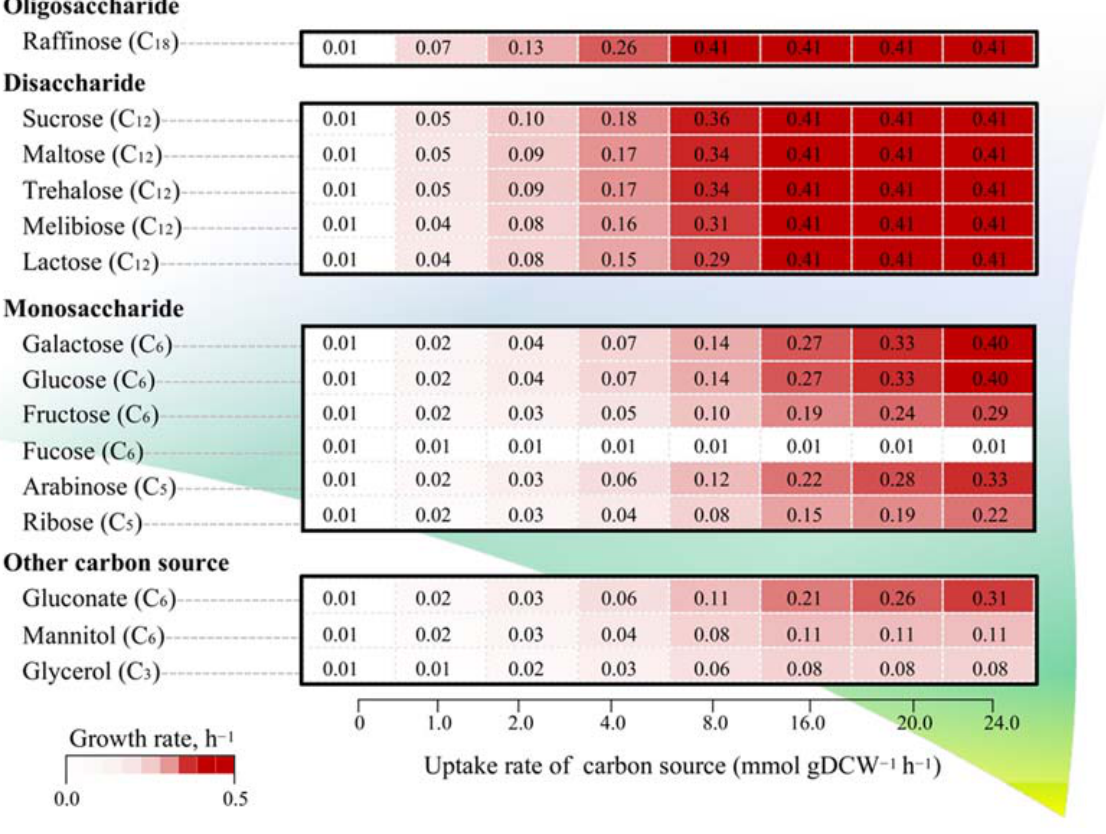
Figure 5. The predicted growth behaviors of L. reuteri KUB-AC5 grown under the different carbon sources. In addition to the color scale, the individual values contained in a matrix also represent the prediction growth rates governed under the different uptake rates of the different carbon sources.